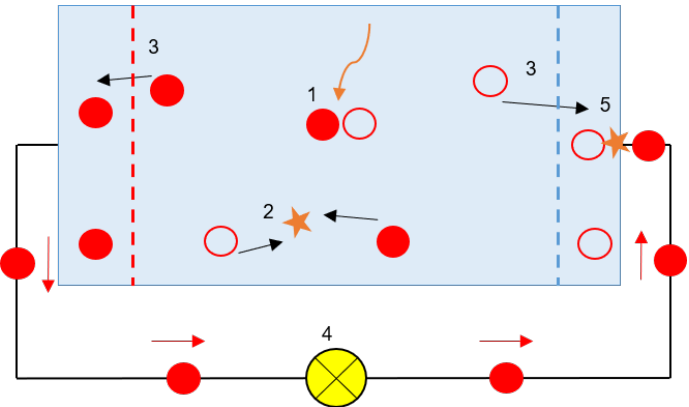
Figure 7. Simple model a solar cell connected to a load (sourced from the work in [43]). That solar cell is a PIN junction, also illustrated in Figure 8. The PIN structure consists of a p region and a n region separated by an intrinsic layer. The p region and n region have different electrons concentration: the n-type has an excess of electrons while the p-type has an excess of holes, i.e., positive charges. The intrinsic layer width W is much larger than the space charge width of a normal PN junction [28–42].